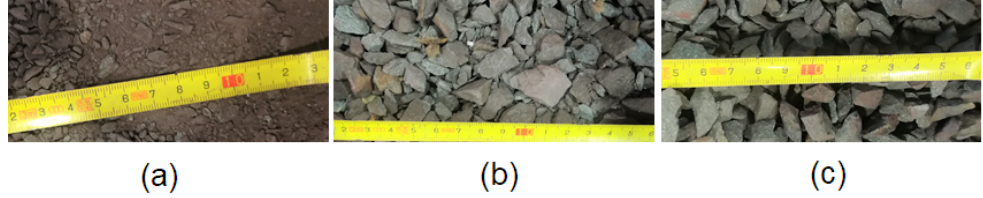
Figure 4. Different lots of hematite ore: ( a ) undersize—US; ( b ) total distribution—TD; ( c )